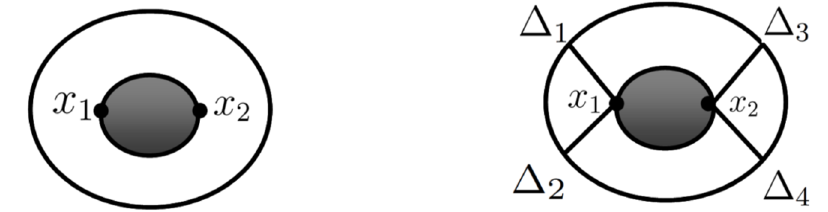
Figure 1 . Left: The grey blob represents a general bulk two point function F ( x 1 ; x 2 ), with points x 1 and x 2 . Other than that, the blob is completely general. Right: Attaching 4 legs to the boundary gives a CFT 4-point function g 4 ( z; (cid:22) z ). This class of diagrams has 2 bulk-to-boundary propagators attached to x 1 , and 2 attached to x 2